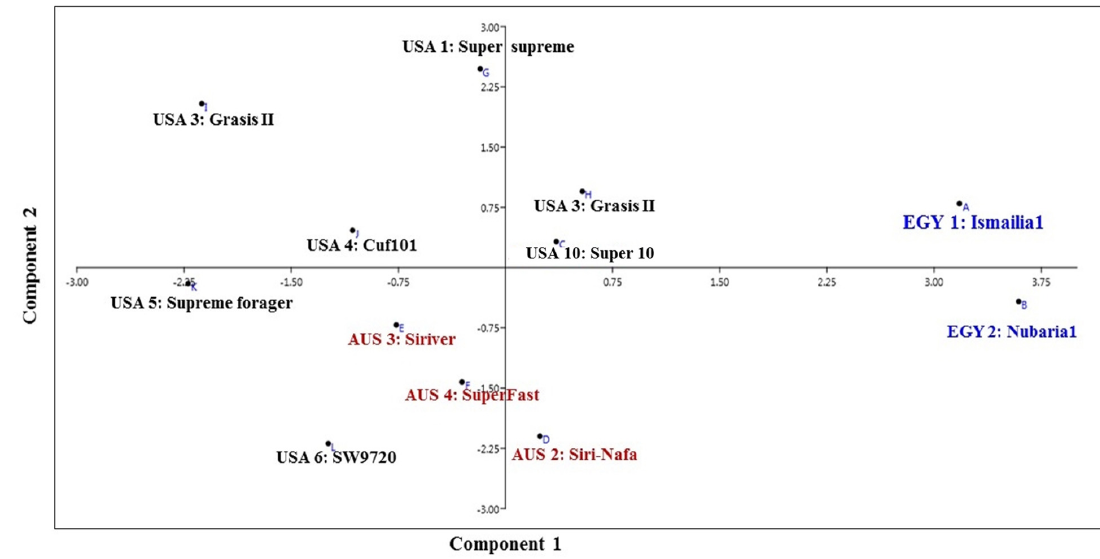
Figure 3. Principal component analysis (PCA) scatter diagram illustrating the genetic diversity expressed by the grouping of 12 M. sativa cultivars based on the analysis of IRAP marker polymorphism and by blotting the first two principal components using PAST software.